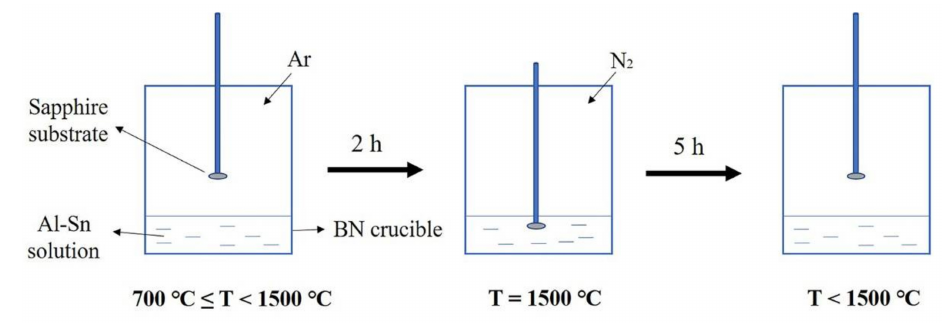
Figure 1. Experimental flow chart.